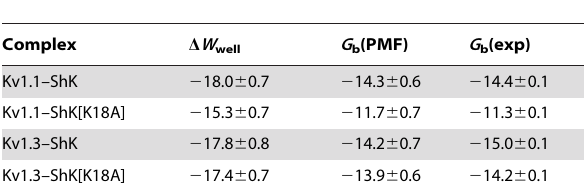
Table 3. The relative and absolute binding free energies obtained from the PMF calculations for the Kv1.x–ShK and